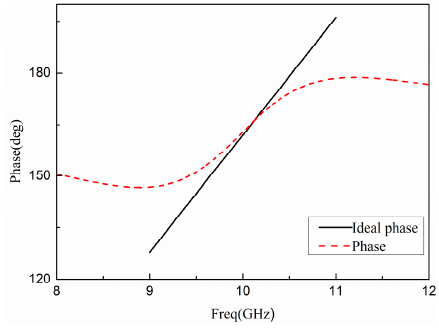
Figure 9. Phase of reflection coefficient.